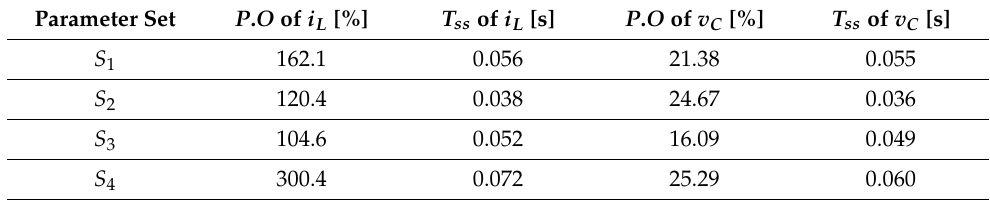
Table 2. Comparison of peak overshoot and settling time across the four different parameter sets. Parameter